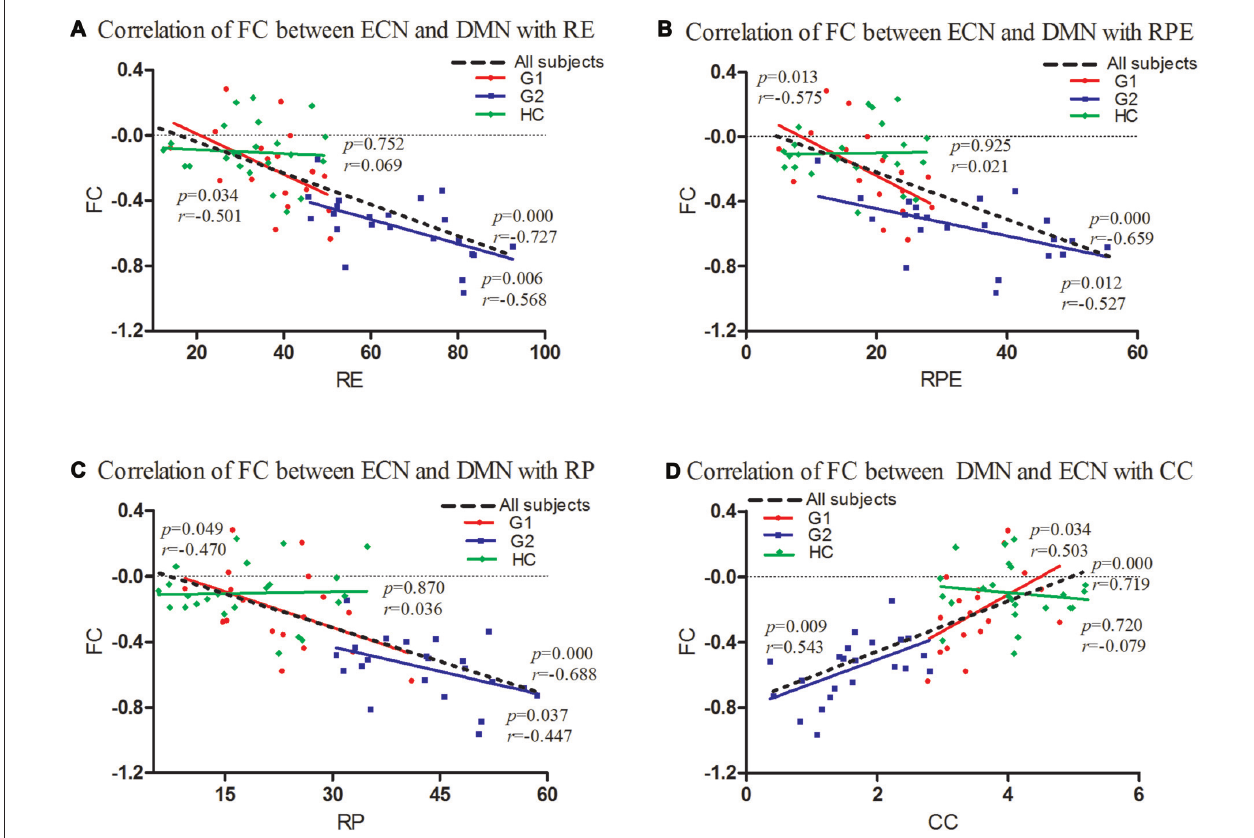
FIGURE 2 | Correlations of FC between ECN and DMN with Wisconsin Card Sorting Test (WCST) scores in all subjects. FC between the ECN and DMN was significantly negatively correlated with perseverative RE (G1: p = 0.034, r = − 0.501; G2: p = 0.006, r = − 0.568; all subjects: p = 0.000, r = − 0.727; A ), RPE (G1: p = 0.013, r = − 0.575; G2: p = 0.012, r = − 0.527; all subjects: p = 0.000, r = − 0.659; B ), RP (G1: p = 0.049, r = − 0.470; G2: p = 0.037, r = − 0.447; all subjects: p = 0.000, r = − 0.688; C ) and had significant positive correlation with CC (G1: p = 0.034, r = 0.503; G2: p = 0.009, r = 0.543; all subjects: p = 0.000, r = 0.719; D ). For HC analysis, no significant correlation was found between FC with WCST scores ( p > 0.05; A–D ). CC, categories completed; DMN, default-mode network; ECN, executive control network; FC, functional connectivity; HC, healthy controls; G1, subgroup 1; G2, subgroup 2; RE, response errors; RP, perseverative responses; RPE, perseverative